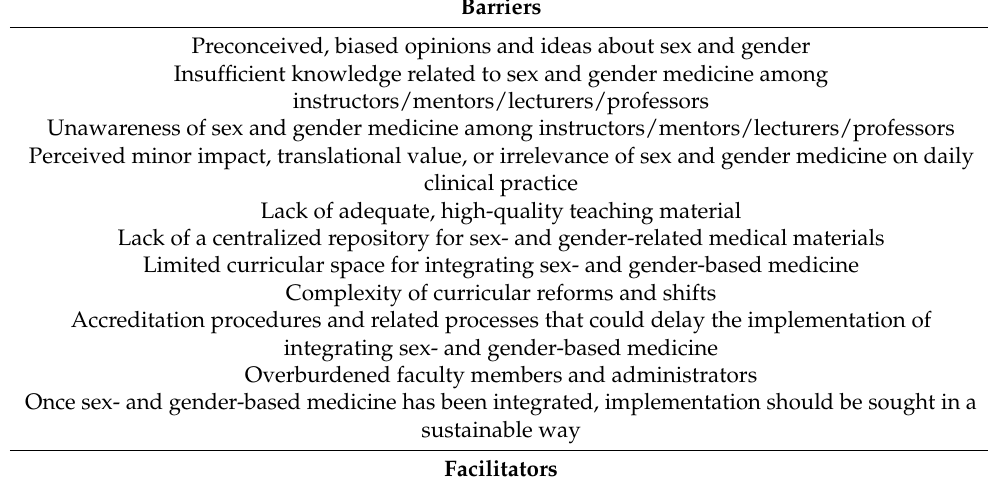
Table 3. Barriers and facilitators of the implementation of sex and gender medicine in biomedical curricula.